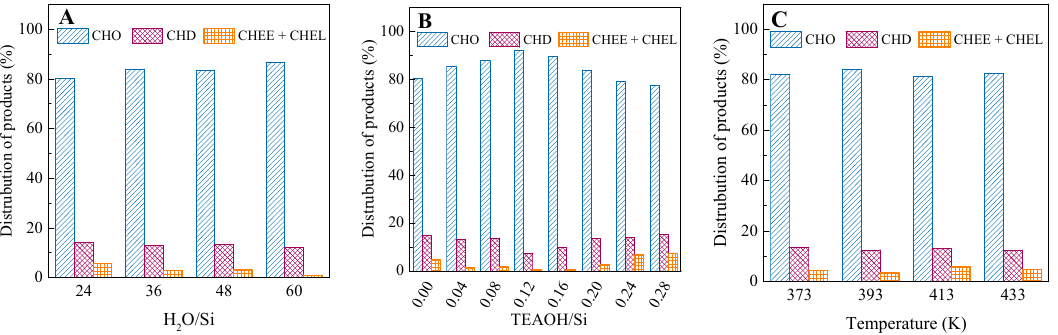
Figure 1. Effects of H 2 O/Si molar ratio ( A ), TEAOH/Si molar ratio ( B ) and treatment temperature ( C ) on the catalytic performance of Re − Ti − Beta in cyclohexene epoxidation. Reaction conditions: catalyst, 0.05 g; cyclohexene, 10 mmol; H 2 O 2 (30 wt.%), 10 mmol; MeCN, 10 mL; temp., 333 K; time, 2 h.